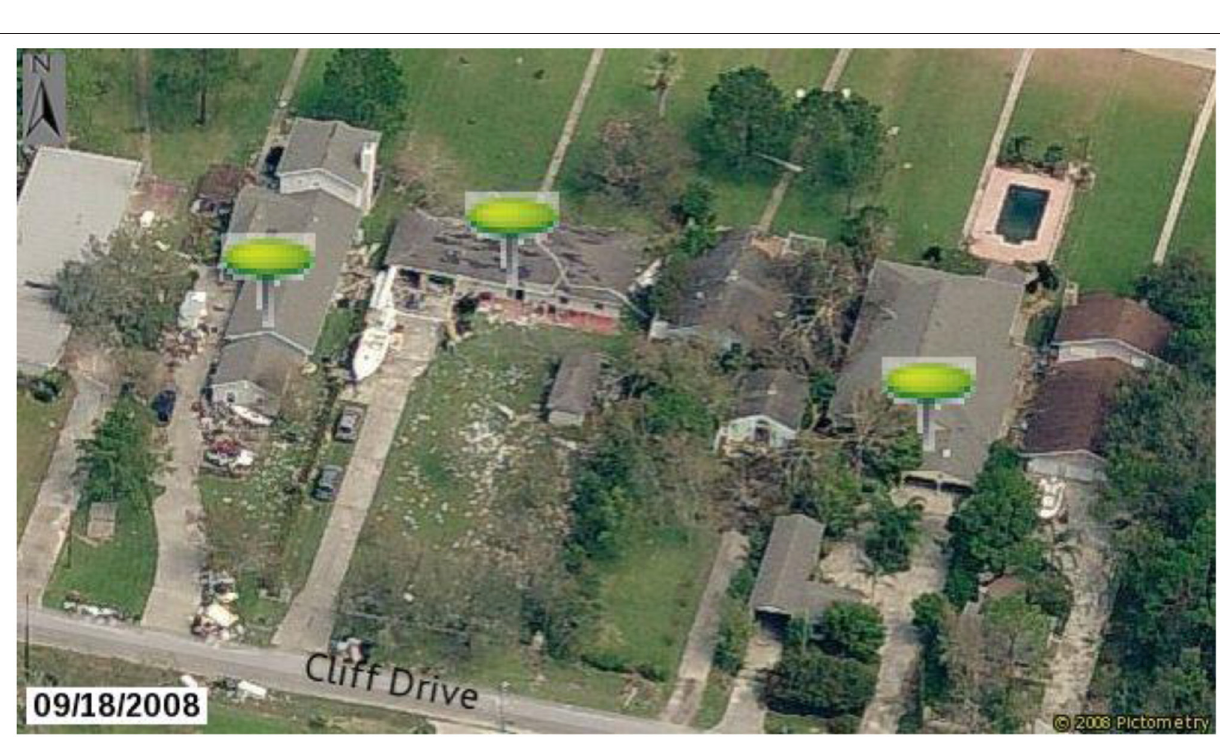
FIGURE 2 | Example oblique Pictometry image shows the condition of roofs and walls for one elevation. Data from additional viewpoint angles can be used to assess damage to the other three elevations of each building. Image resolution and quality reduced for publication. Pin icons denote houses that were included in the dataset. Varying colors of pins were for internal organization purposes only. Image courtesy of Eagleview Technologies,